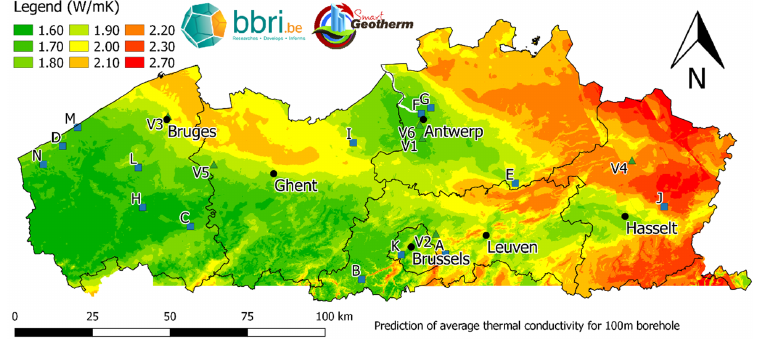
Figure 21. Prediction of the average thermal conductivity in Flanders over a depth of 10 m or up to bedrock. The available TRT results for thermal conductivity calibration are indicated by letters A to N. The TRT results used for verification of the maps are indicated by V1 to V6.